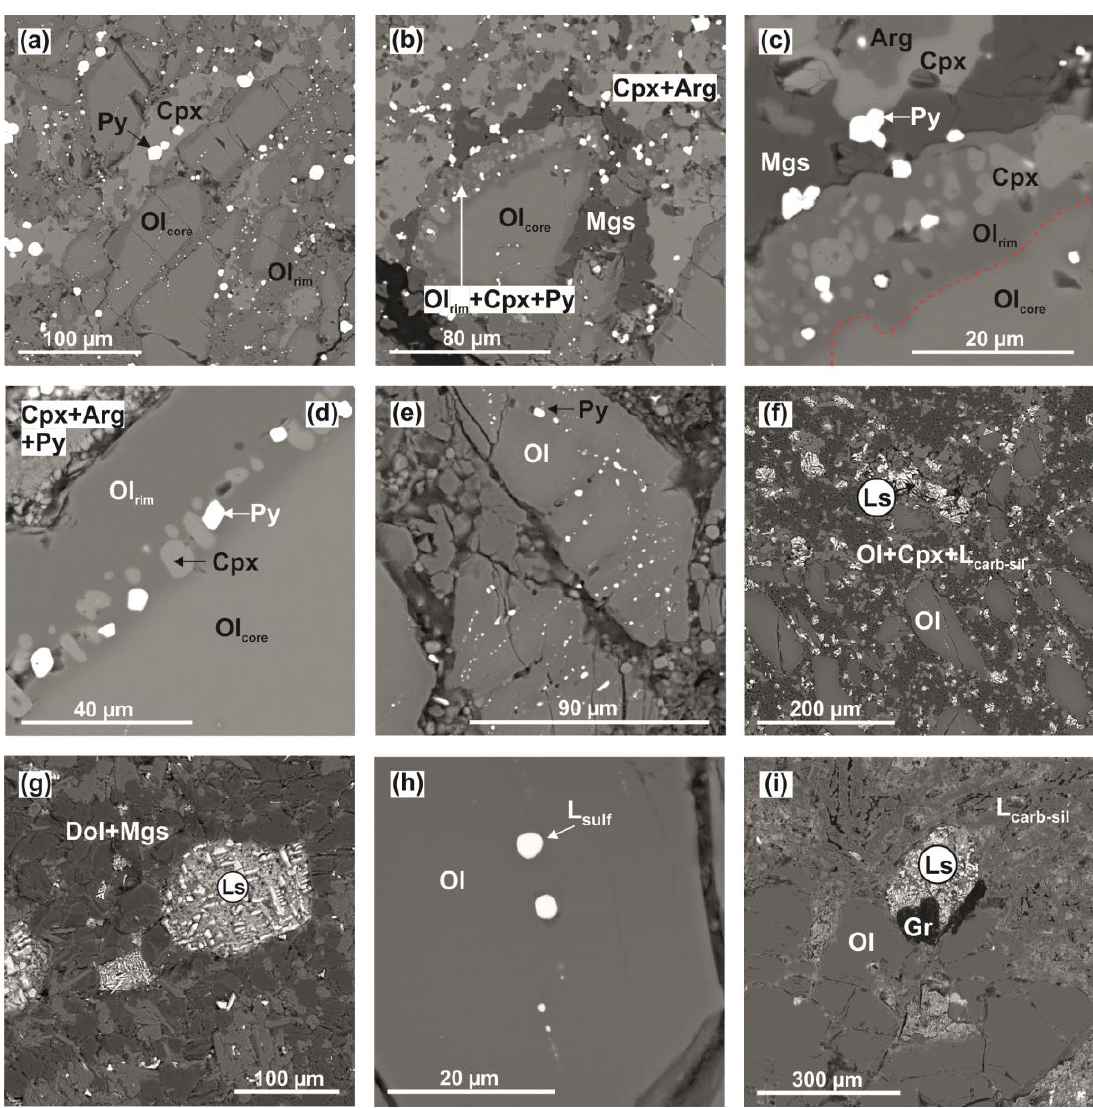
Figure 2. Scanning electron microscope (SEM) micrographs of polished fragments of samples produced in the olivine-ankerite-sulfur system: ( a , b )—polycrystalline olivine aggregate with fine-crystalline olivine, clinopyroxene, magnesite, and aragonite in the interstices (1050 ◦ C); ( c )—structure of the reaction zones around recrystallized olivine (1050 ◦ C), ( d )—pyrite and diopside inclusions in recrystallized olivine (1150 ◦ C); ( e )—recrystallized olivine with pyrite inclusions (1250 ◦ C); ( f )—polycrystalline aggregate of recrystallized olivine, clinopyroxene, and dolomite, as well as pools of a quenched sulfur melt (1350 ◦ C); ( g )—droplets of a quenched sulfur melt in a polycrystalline dolomite + magnesite aggregate (1450 ◦ C); ( h )—recrystallized olivine with sulfide inclusions (1450 ◦ C); ( i )—large crystals of graphite at the contact between recrystallized olivine and quenched sulfur- and carbonate-silicate melts (1550 ◦ C); Ol—olivine, Cpx—clinopyroxene, Py—pyrite, Mgs—magnesite,